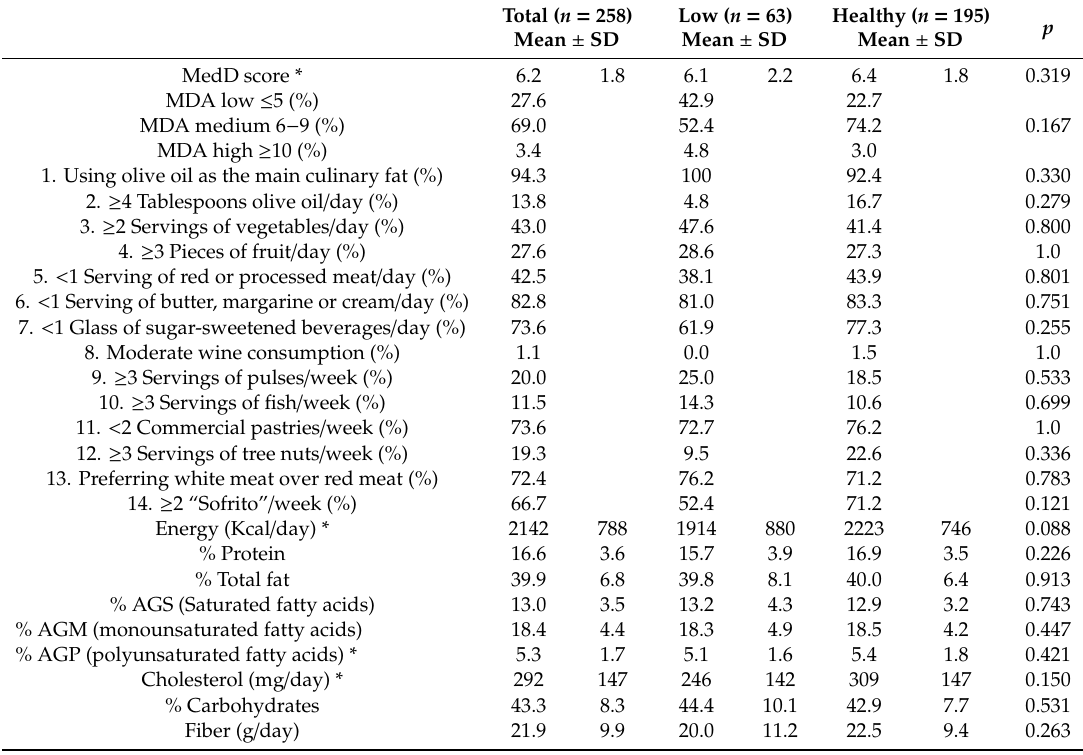
Table 4. Mediterranean diet adherence and 24-h dietary recall (two days) data by VO 2max (low and healthy).